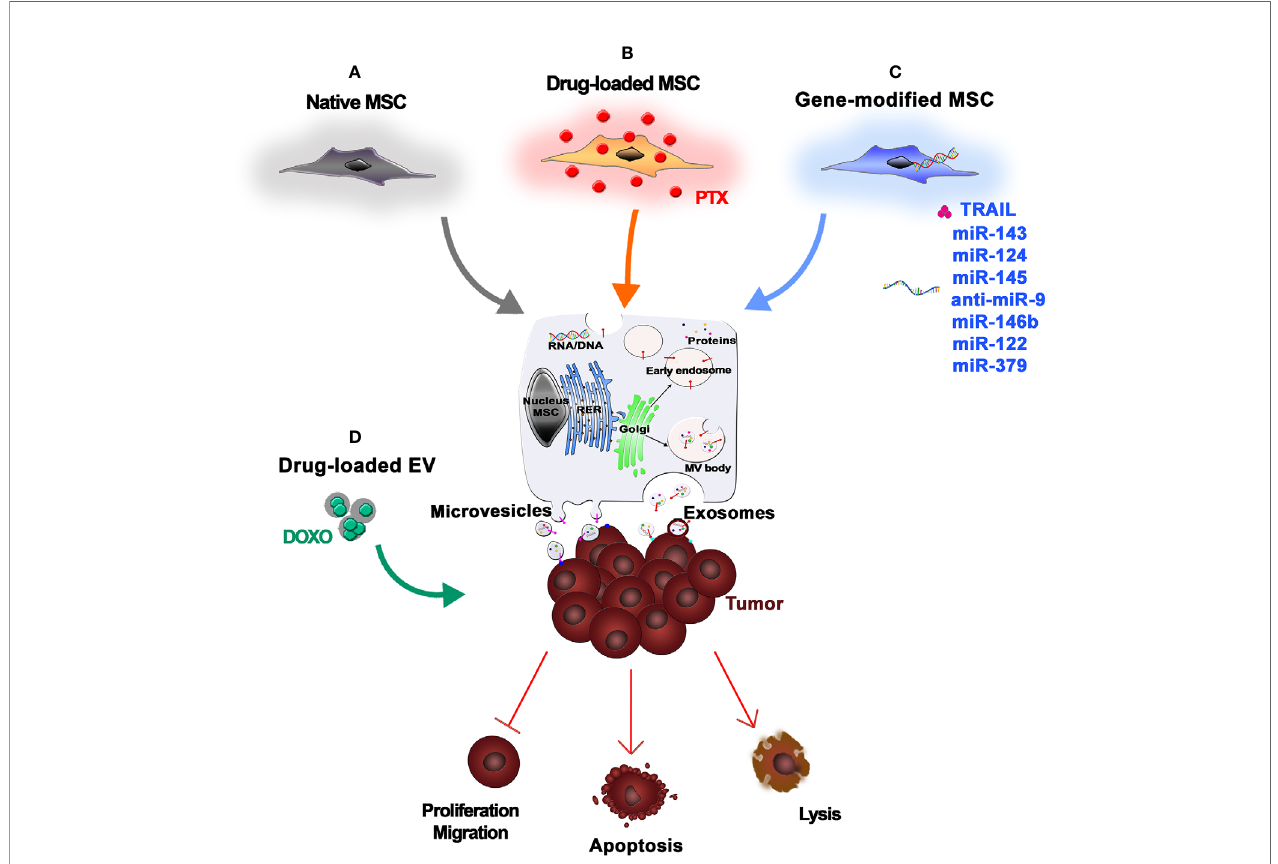
FIGURE 2 | Mesenchymal stromal/stem cell (MSC)-Extracellular Vesicles (EVs) as anticancer drugs. (A) Native MSCs are a reliable source of EVs, which are able to in fl uence tumor cell proliferation, migration, and invasion. (B) Upon in vitro exposure to chemotherapeutic agents [e.g., paclitaxel (PTX)], MSCs internalize and pack the drugs into therapeutic EVs that can ef fi ciently deliver the active drugs to the neoplastic tissue, thus inducing tumor cell apoptosis or lysis. (C) MSCs can also be genetically modi fi ed to express anticancer molecules (e.g., TRAIL) or miRNAs that can be secreted by MSC-derived EVs. (D) Alternatively, EVs are isolated from MSCs and then loaded with drugs or biological cargo by simple diffusion or